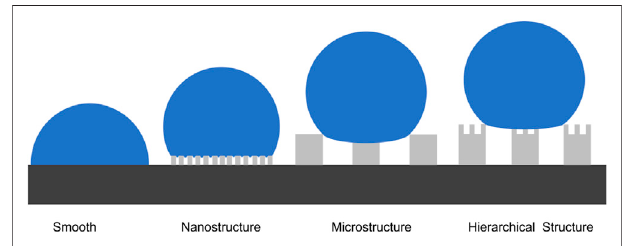
FIGURE 3 | Schematic illustration of the water droplet on the differently structured